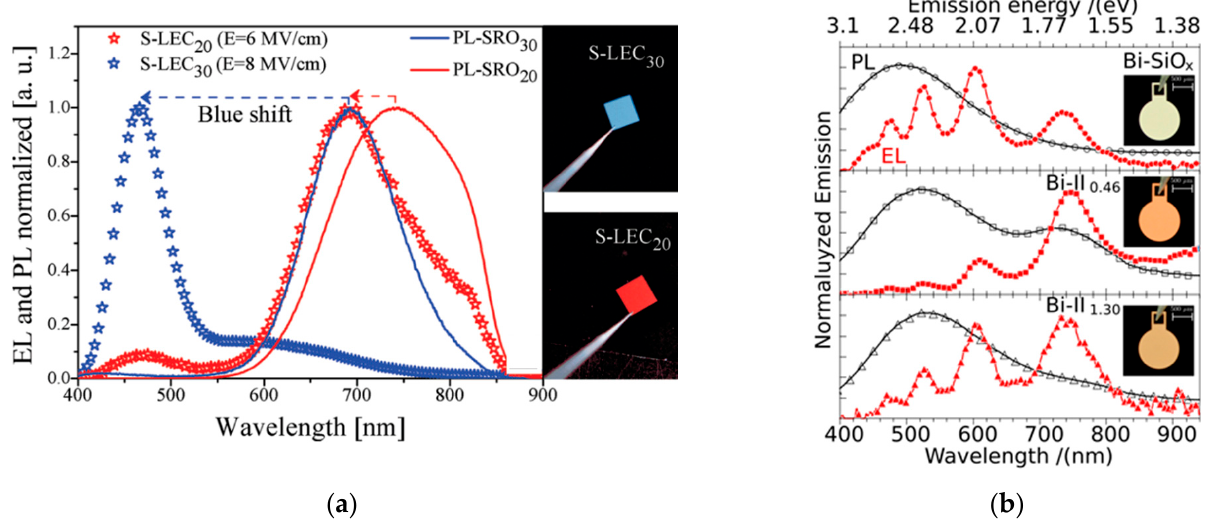
Figure 3. (a) Micrographs and EL spectra of LPCVD-SRO LECs ( a ) [16]; (b) II-SRO/Si 3 N 4 LECs [24]. Figure 3. ( a ) Micrographs and EL spectra of LPCVD-SRO LECs [16]; ( b ) II-SRO/Si